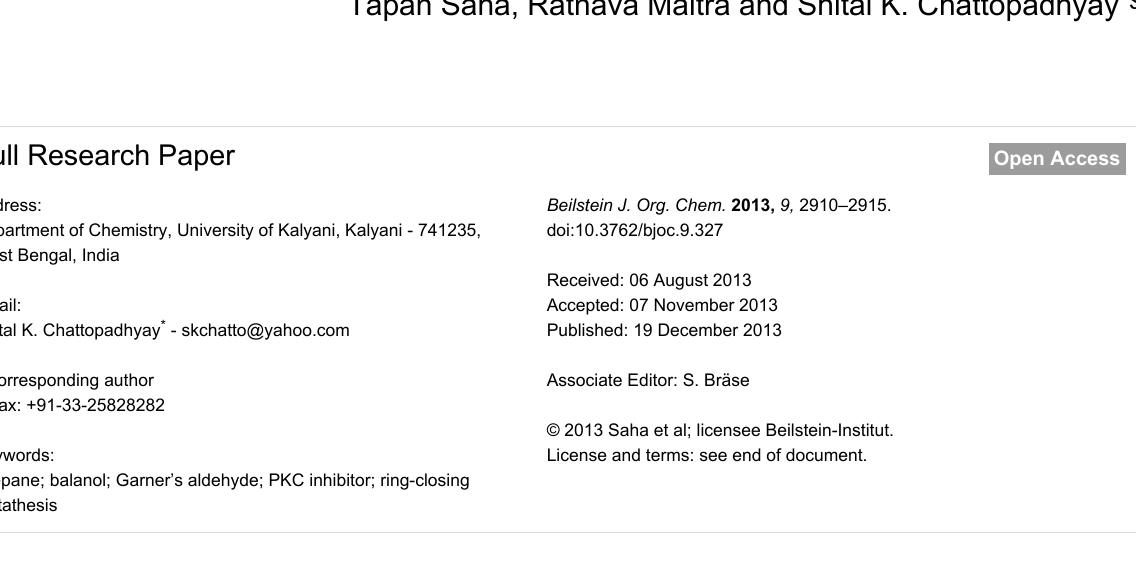
the ATP-docking site of protein kinase, all the three distinct domains present in the natural product such as the benzo- phenone core [50-52], the azepine core [53-59] and